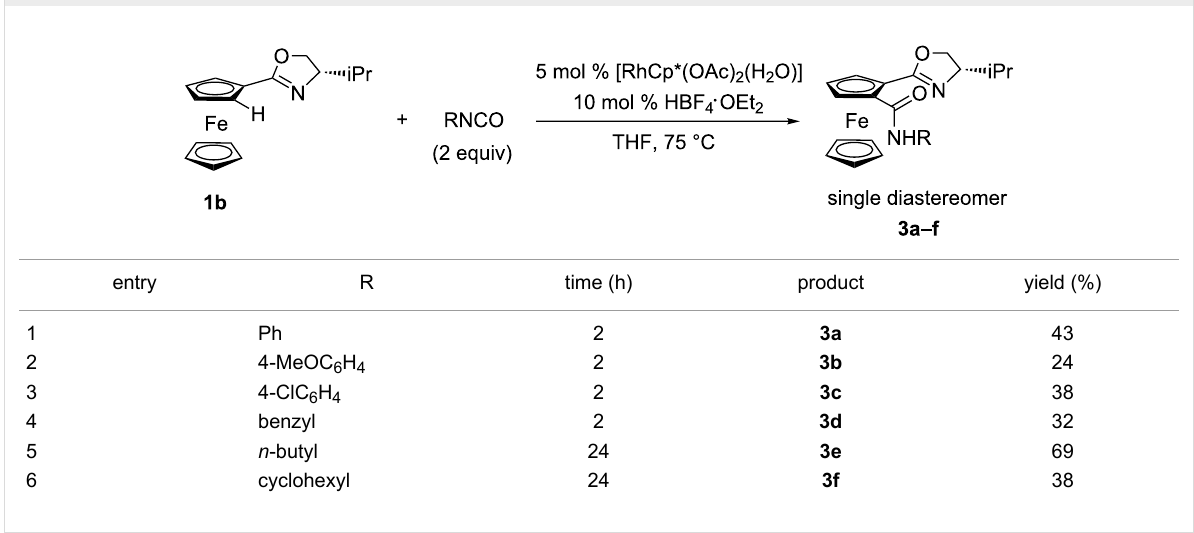
Table 3: Diastereoselective reaction by using chiral oxazolyl ferrocene 1b